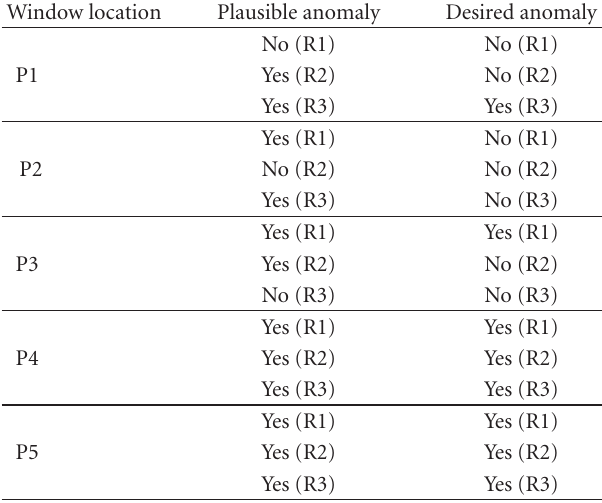
Table 1: Plausible versus desired declarations of local anomalies . Window location